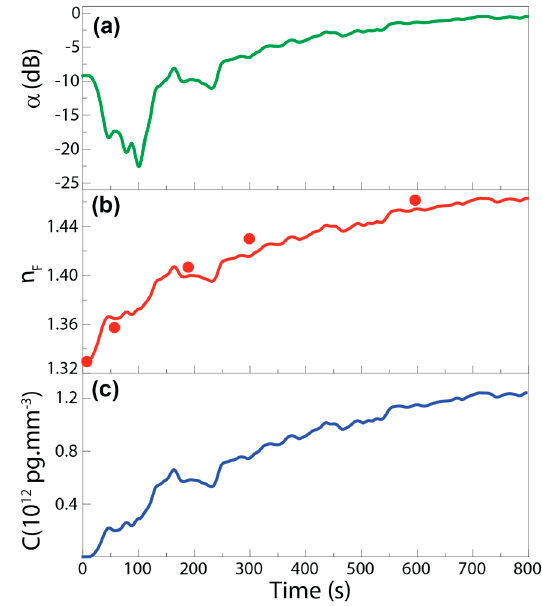
Figure 5. Temporal evolution of the ( a ) MZI sensor optical power loss, ( b ) n F , and ( c ) E. coli concentration. The solid circles in ( b ) correspond to the values estimated by the spectral shift analyses.